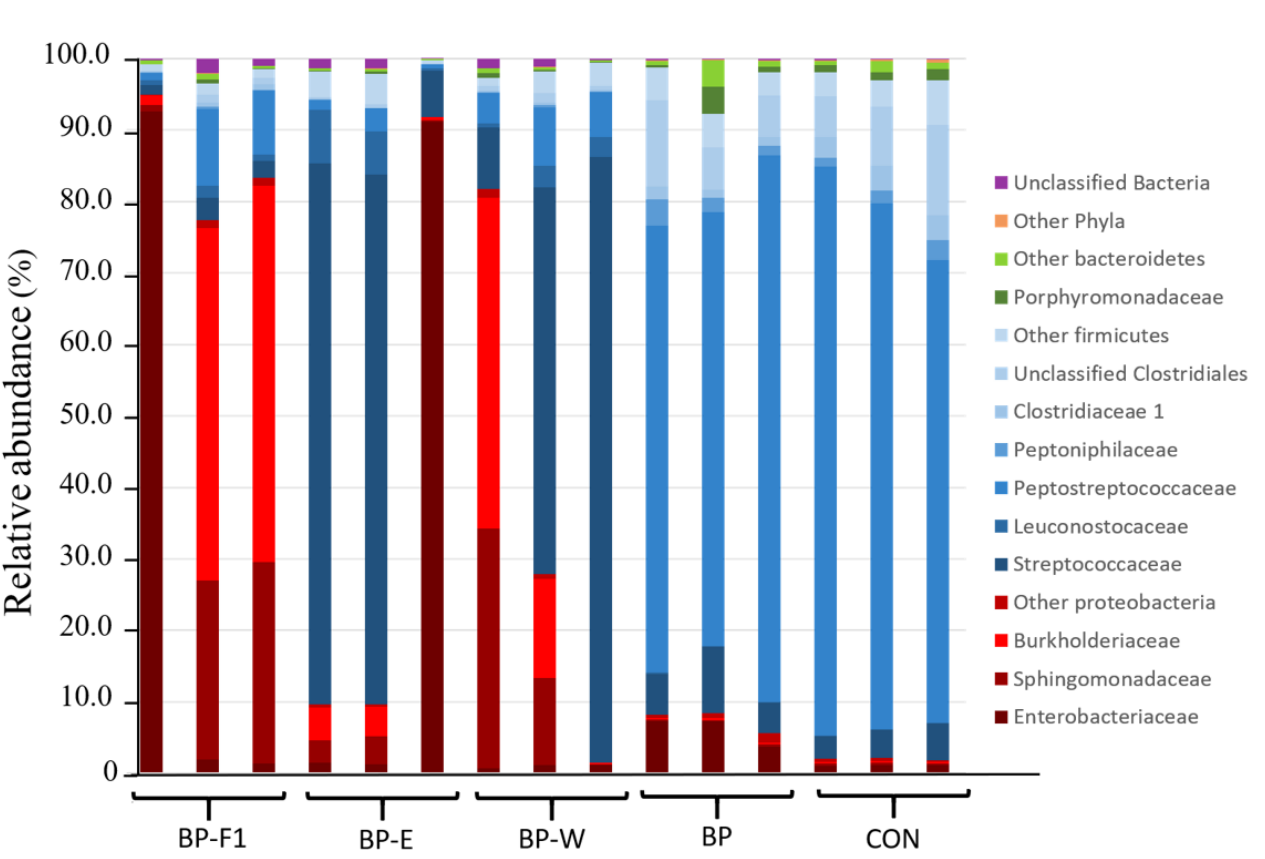
Figure 1. Taxonomic profiles at the phylum and family levels of intestinal bacterial communities of hybrid striped bass. Families belonging to the same phylum are represented by different shades of the same color: Firmicutes (blue), Bacteroidetes (green), and Proteobacteria (red).